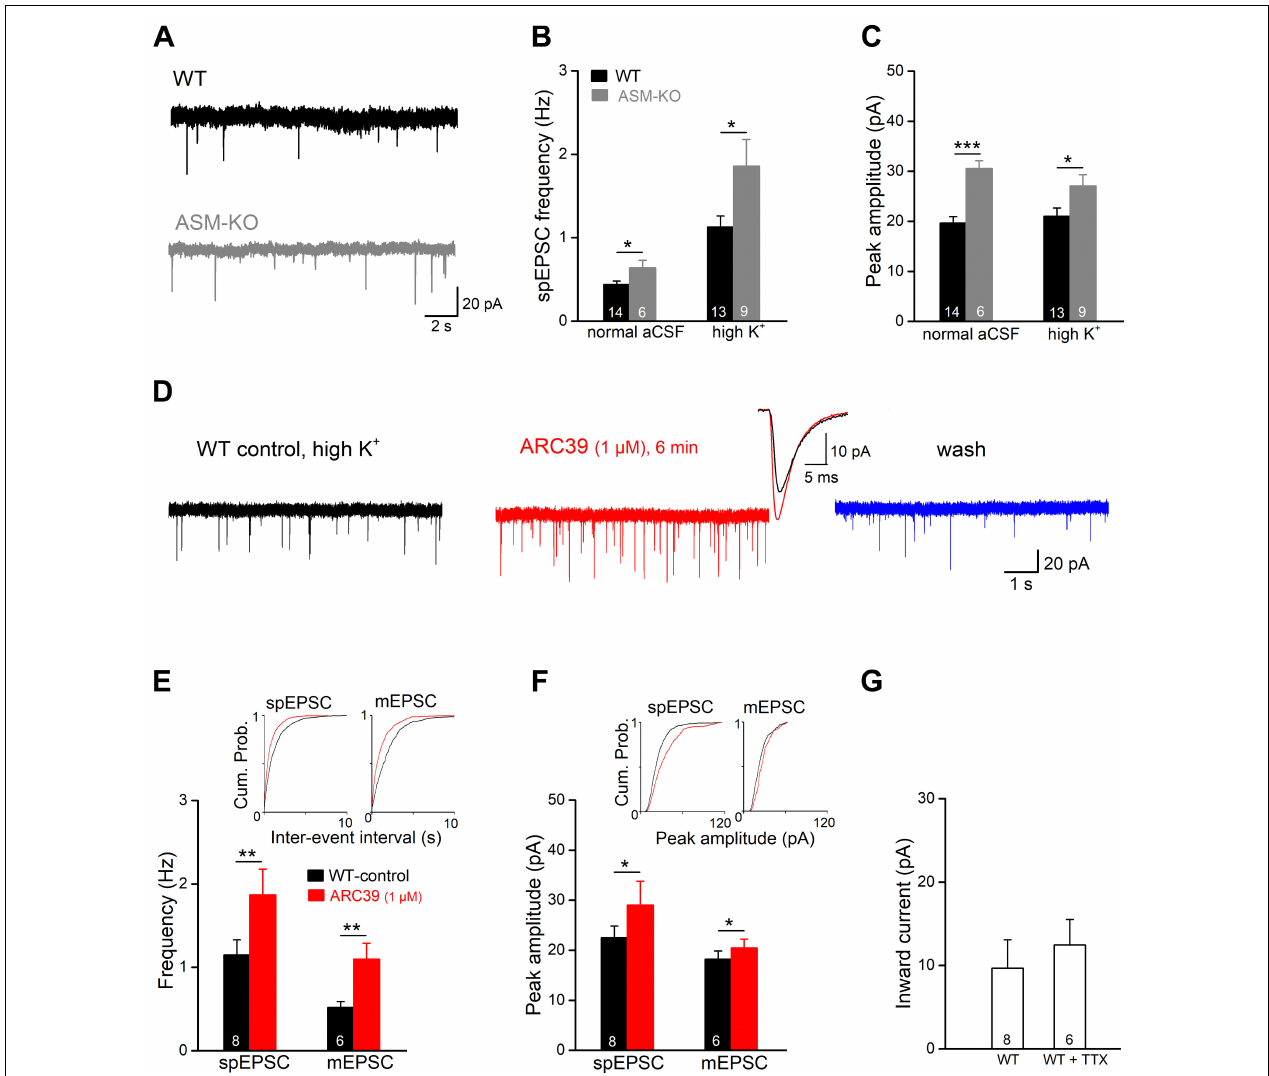
FIGURE 2 | ARC39 increases frequency and amplitude of EPSCs in CA1 pyramidal cells. Spontaneously occurring excitatory postsynaptic events were recorded in the whole-cell voltage-clamp configuration at –70 mV in PTX (100 µ M). Spontaneous EPSCs (spEPSC) and miniature EPSCs (mEPSCs) were collected in the absence and presence of TTX (0.5 µ M), respectively. (A) Raw traces of spEPSCs from a wt cell (black trace) and an ASM-KO cell (gray trace) were collected in aCSF with normal K + concentration (3 mM). (B,C) spIPSCs in ASM-KO pyramidal cells were more frequent and larger in amplitude in both solutions with normal K + (3 mM) and with elevated K + concentration (6 mM, to enhance synaptic events). (D) Raw traces of spEPSCs from a wt cell were collected in solution with high K + (6 mM) before ARC39 application (control), 6 min in ARC39 (1 µ M) and after 10 min of wash. Superimposed traces represent averaged events from same cell before (black trace) and during drug application (red trace). (E–G) Histograms summarize effects of acutely applied ARC39 (1 µ M) on frequency (E) and averaged amplitude (F) of spEPSCs and mEPSCs in wt pyramidal cells, and concomitant shift of holding current (G) . Insets above in panels (E,F) are the cumulative probability plots for inter-event interval (reciprocal of frequency) and peak amplitude. * p < 0.05, ** p < 0.01, and *** p <